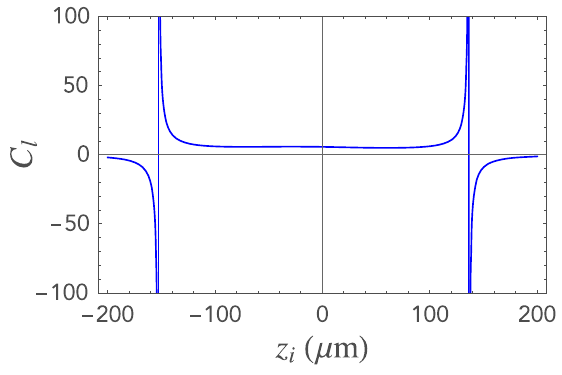
FIG. 10. Local compression ratio, C l varying with the initial longitudinal position, z i . Where C l is negative, this indicates that the electrons with those initial z i values are in fact spreading out rather than compressing.